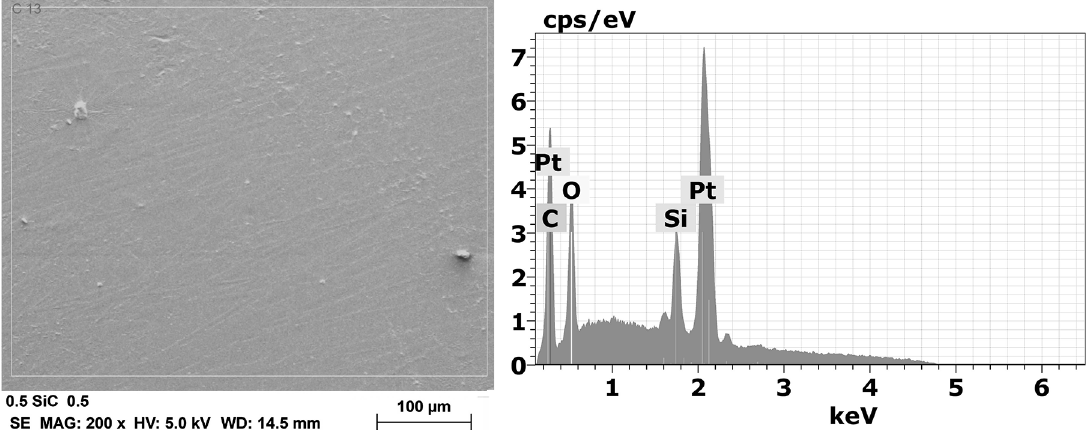
Figure 7. SEM image of the PMMA matrix containing 0.5% treated SiC amount and confirmed by spectrum of the energy dispersive X-ray spectroscopy (EDS)